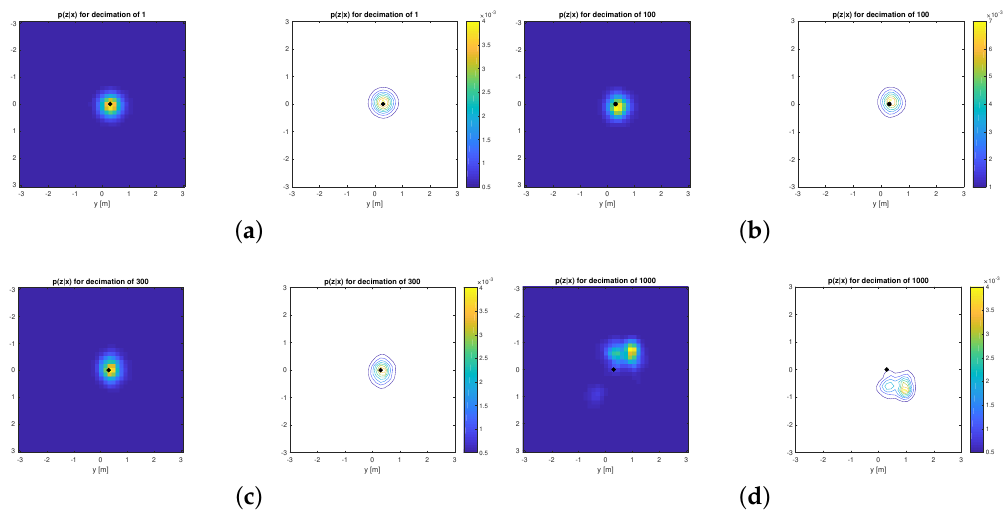
Figure 4. Some planar slices of 6D likelihood functions evaluated for different decimation ratios, as both an intensity color plot and a contour diagram. Ground-truth vehicle pose is marked as a large block dot in all the figures. ( a ) Original p.d.f. p ( z | x ) ; ( b ) Approximate ˆ p ( z | x ) for D = 100; ( c ) Approximate ˆ p ( z | x ) for D = 300; ( d ) Approximate ˆ p ( z | x ) for D = 1000.